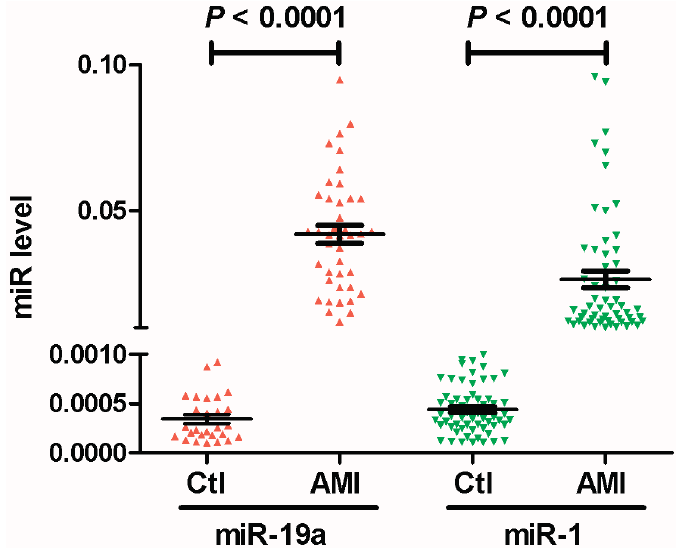
Figure 1. Circulation miR-19a and miR-1 level from acute myocardial infarction (AMI)